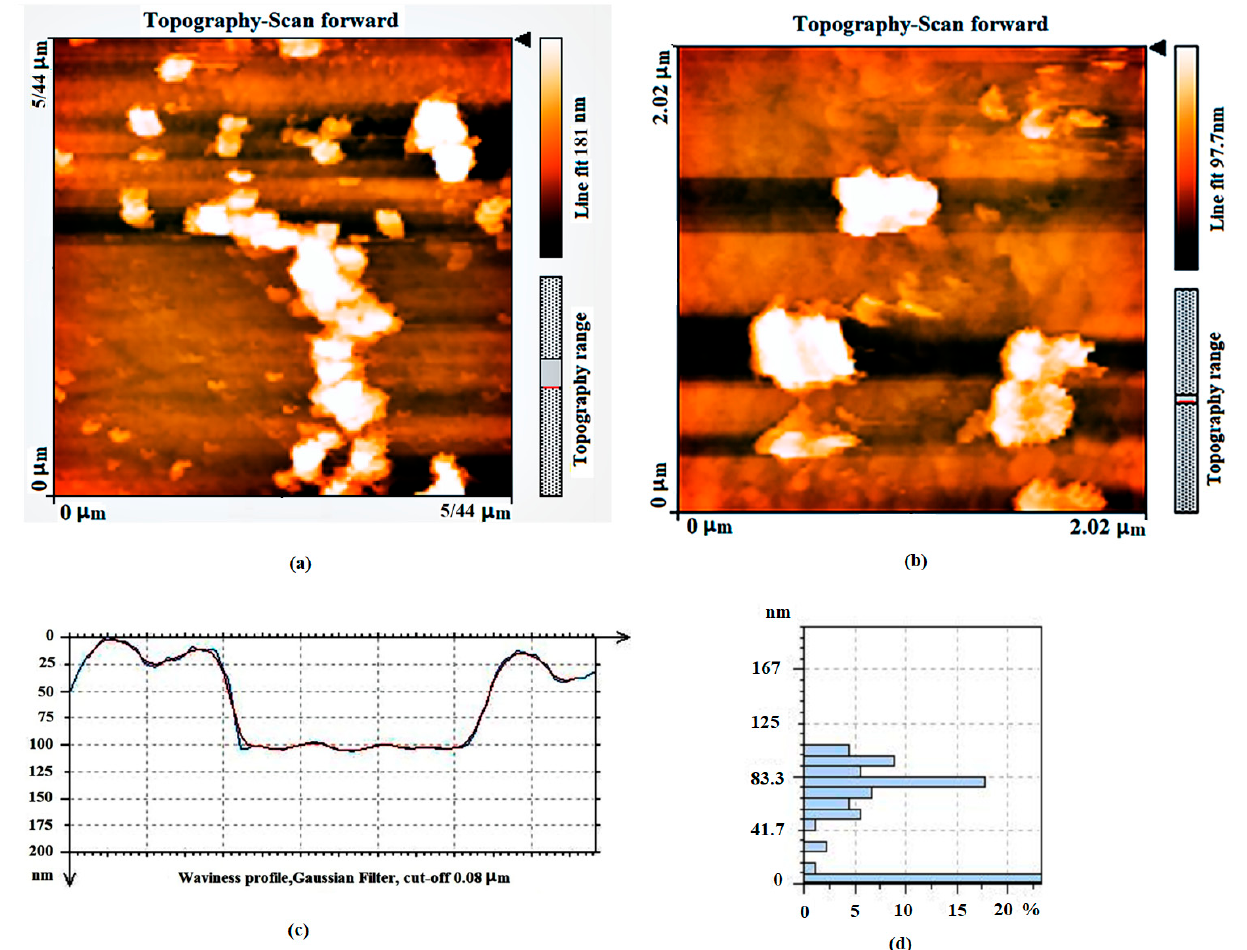
Figure 2. ( a , b ) AFM topography images and phase chart of chemical reduced graphene and ( c ) an equivalent height profile, ( d ) pore size distributions.